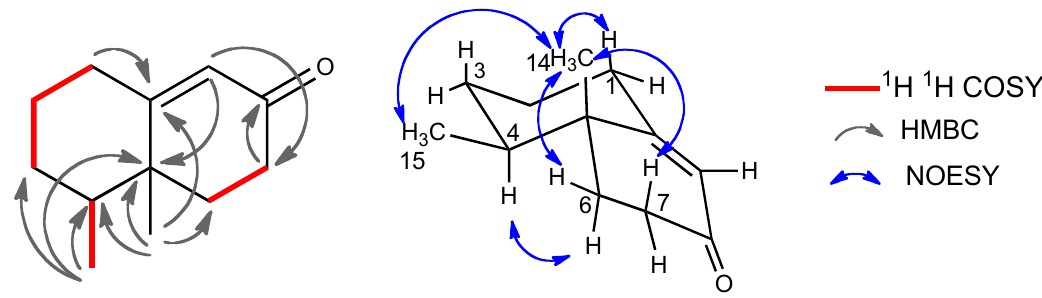
Figure 5. Selected 2D correlations for compound 4